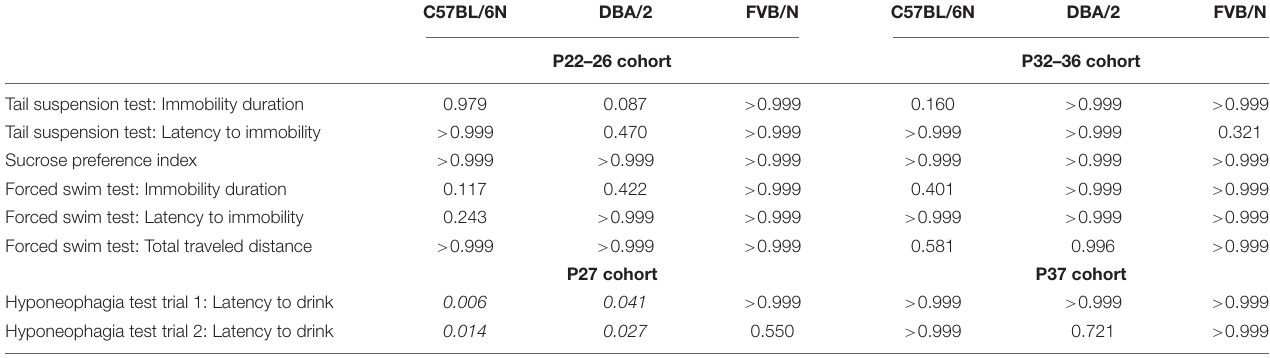
TABLE 2 | List of the P values of the comparison between male and female mice of C57BL/6N, DBA/2, and FVB/N strains in the behavioral test battery.